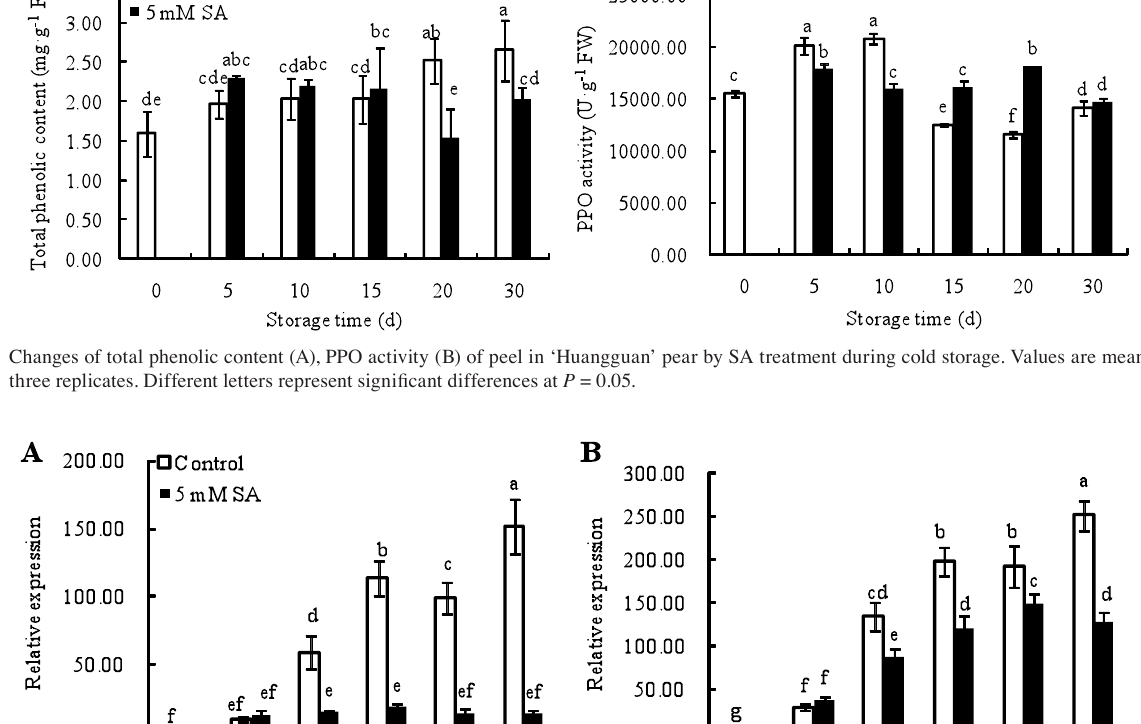
is consistent with the results on pineapple, papaya, apricot and peach fruits (L u et al., 2010; P romyou and S upapvanich , 2016; W ang et al., 2015; W ang et al.,